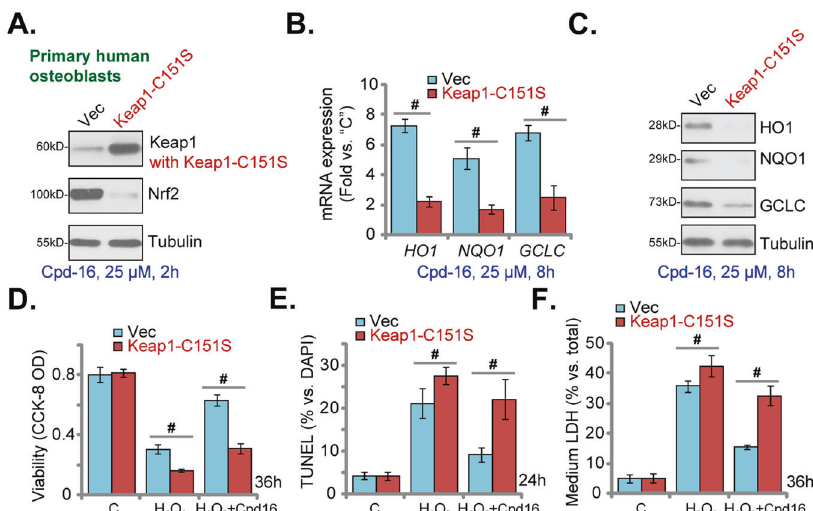
Fig. 7 Keap1 Cys151S mutation abolishes Cpd16-induced Nrf2 cascade activation and osteoblasts cytoprotection. Stable primary human osteoblasts with Cys151S Keap1 ( “ Keap1-C151S ” ) or Vector were treated with Cpd16 (25 μ M), listed proteins and genes were measured ( A – C ). Alternatively, the primary human osteoblasts were pretreated with Cpd16 (25 μ M) for 2 h, followed by H 2 O 2 (400 μ M) stimulation, and cell viability, apoptosis, and necrosis were tested by CCK-8 ( D ), TUNEL-nuclei staining ( E ), and LDH releasing F assays, respectively. # P <